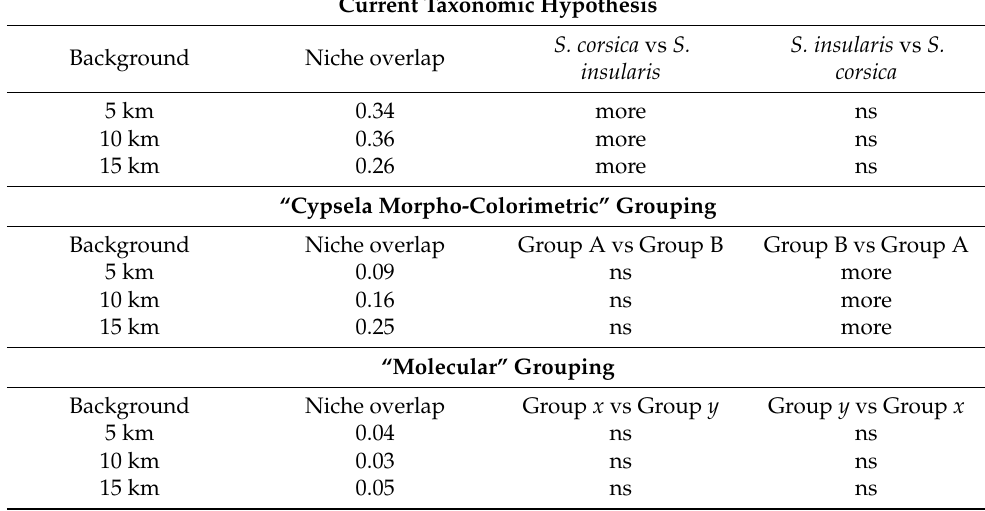
Table 13. Results of niche overlap and niche similarity tests for the current taxonomic hypothesis and two alternative groupings in Santolina . In the alternative grouping derived from cypsela morpho- colorimetric results, “Group A” is composed of the populations of S. insularis from central-eastern Sardinia, while “Group B” is composed of S. corsica and the populations from south-western Sardinia. In the alternative grouping derived from molecular results, Group x is composed of populations from south-western Sardinia, while Group y is composed of the remaining populations. Backgrounds are defined by applying 5, 10, and 15 km buffer zones around the occurrence points. Significant results are indicated by ‘less’ for significant divergence or ‘more’ for significant similarity between tests. “ns” (not significant) when p >